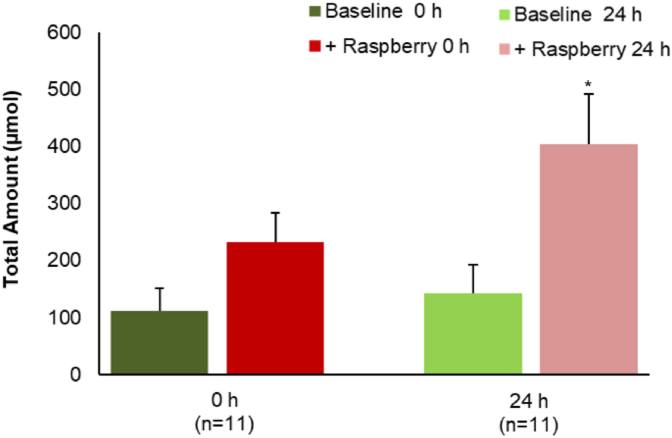
Total amount of phenolic acids and aromatic catabolites present in ileal fluid before (baseline) and after (+raspberry) raspberry consumption analysed before (0 h) and after (24 h) fecal fermentation. Data expressed as μmol ± SEM (n = 11). Significance compared Baseline vs + Raspberry using One-way ANOVA and Dunnett T test, **p < 0.05.